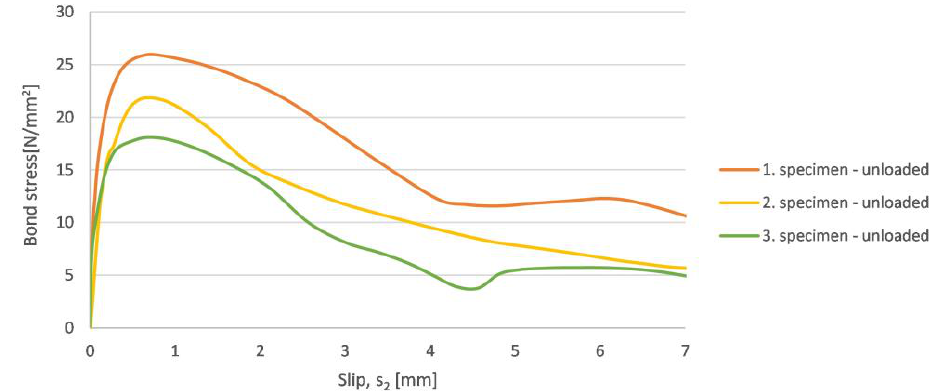
Table 6. Bond stress of NWAC. Figure 10. Bond stress–slip diagram of NWAC. Figure 10. Bond stress – slip diagram of NWAC.